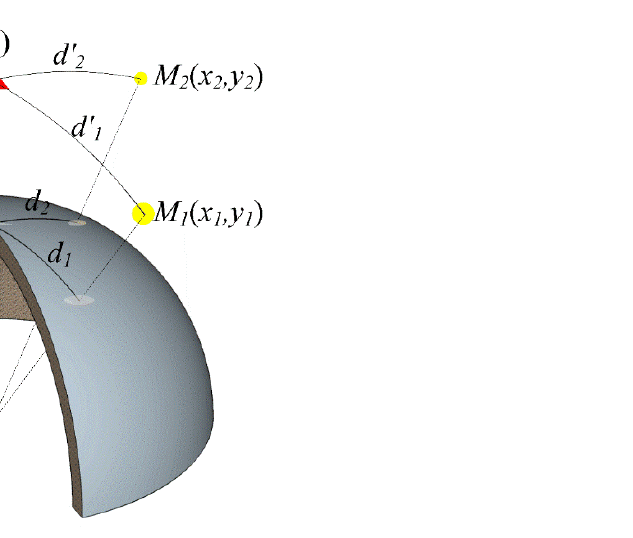
Figure 2. Inverse distance weighting (IDW) method in consideration of the Earth’s curvature.